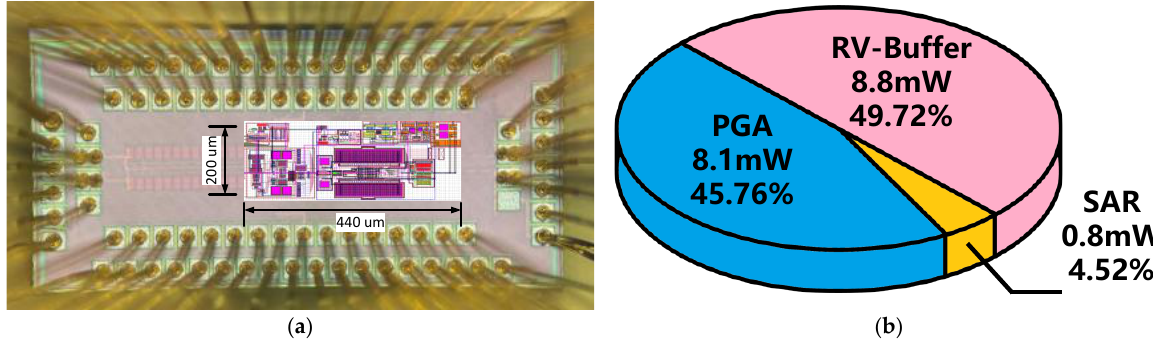
Figure 11. ( a ) The chip photograph with detailed layout; ( b ) power breakdown.